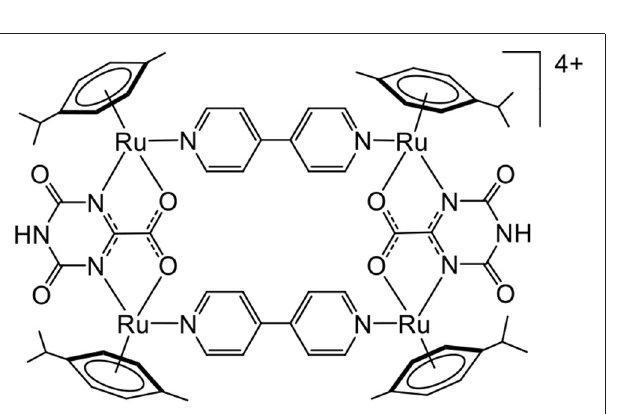
coordination of ligands on metals (Therrien, 2009), which allows the design of 2D and 3D entities (Cook et al., 2013; Singh et al., 2014; Therrien, 2018). These metalla-assemblies possess different functional groups, situated either at the periphery or at the core of the assembly. They have